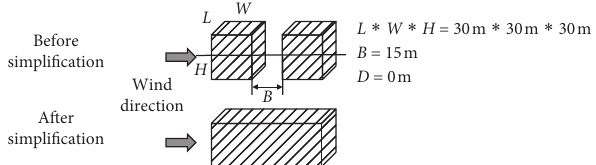
Figure 4: The initial model of the single factor experiment.